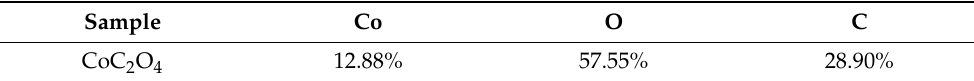
Table 4. EDS analysis of CoC 2 O 4 .